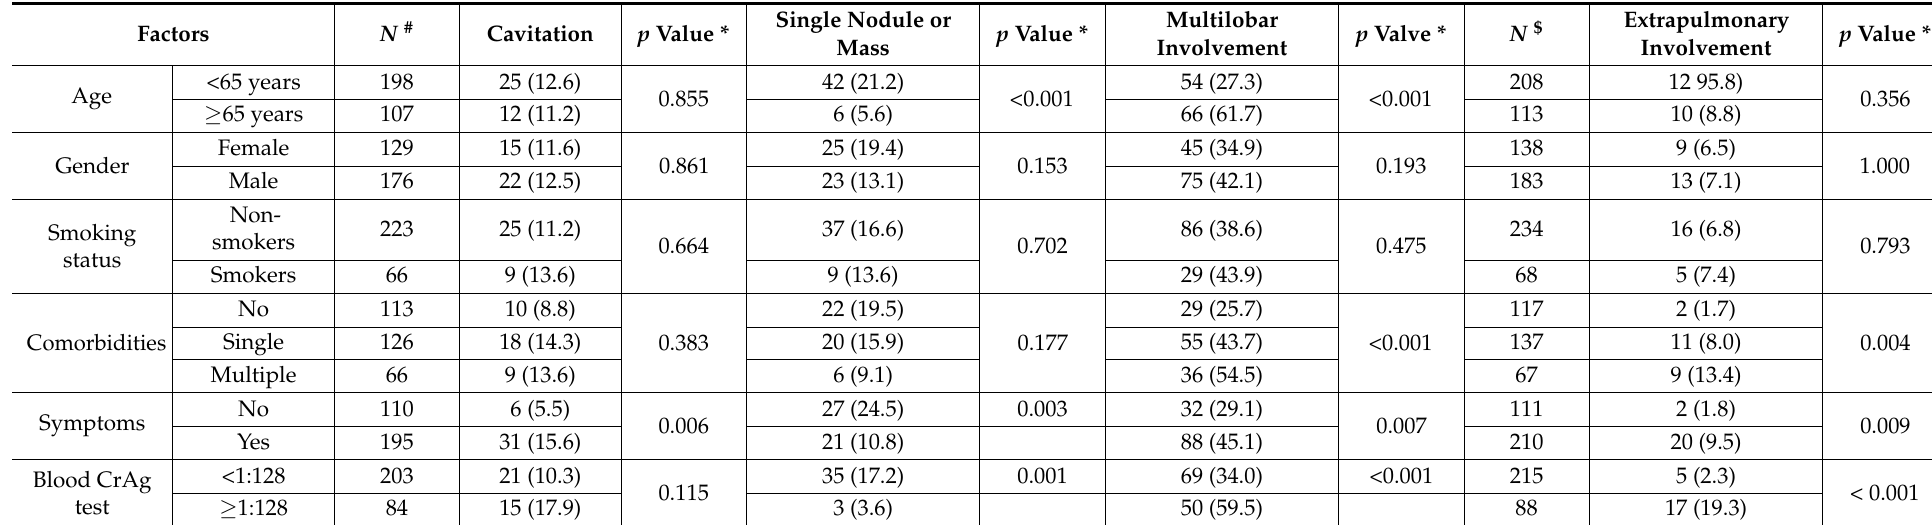
Table 5. Univariate analysis of radiological presentations and the extent of